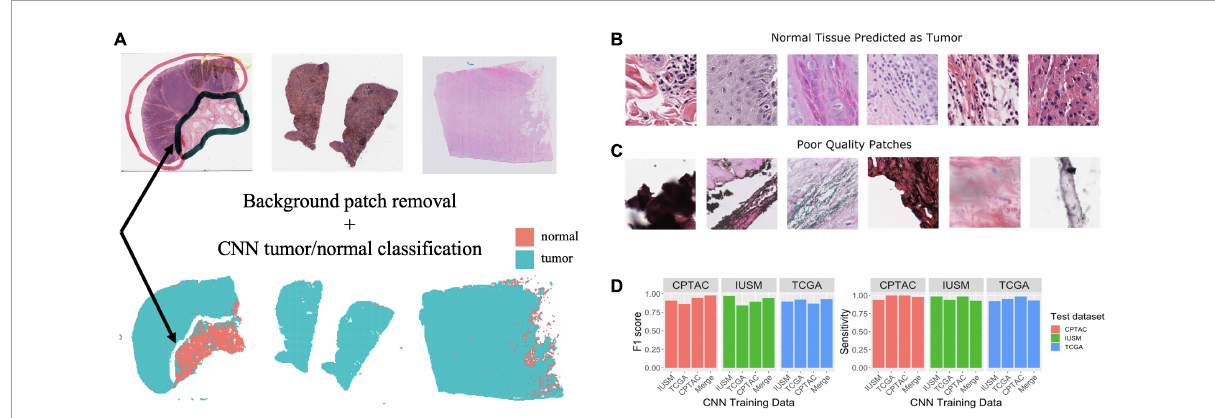
FIGURE2 Training and assessment of convolutional neural network. Workflow and assessment of convolutional neural network. (A) Whole slide image patches are first filtered to remove background patches. This step removes artifacts, demonstrated by the ink from the whole slide images (WSI) that is not retained in the final set of patches (arrow). (B) Patches confused by the convolutional neural networks (CNN) can show mitotic figures and dense lymphocytic infiltrate. (C) Despite our filtering steps, there remain some artifact-ridden poor-quality patches. (D) Performance at epoch 200 for CNNs trained on the IU School of Medicine (IUSM), The Cancer Genome Atlas (TCGA), Clinical Proteomic Tumor Analysis Consortium (CPTAC), and merged datasets, comparing the Fl scores and sensitivity for tumor/normal classification achieved on validation sets from the IUSM, TCGA, and CPTAC